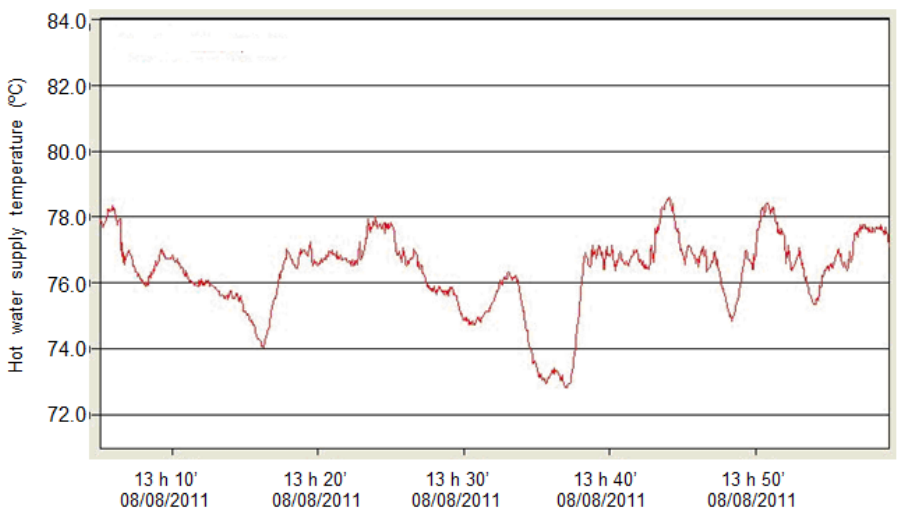
Figure 8. Boiler 5: Hot water supply temperature evolution (°C) forone hour, implementing actions 1 and